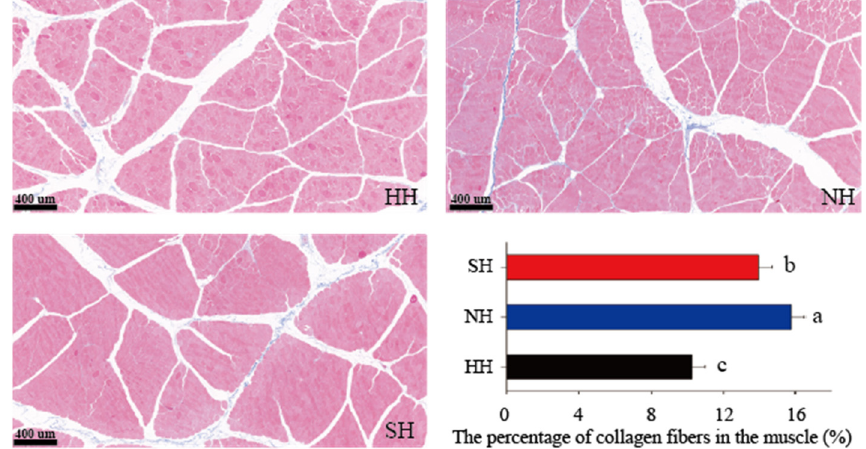
Figure 2. Collagen fiber content in F 1 crossbred lambs using masson staining. Scale bars, 400 µm. All data were expressed as mean ± SD ( n = 3). Different letters indicate significant differences at p < 0.05. HH: Hu × Hu, NH: Southdown × Hu, SH: Suffolk × Hu.